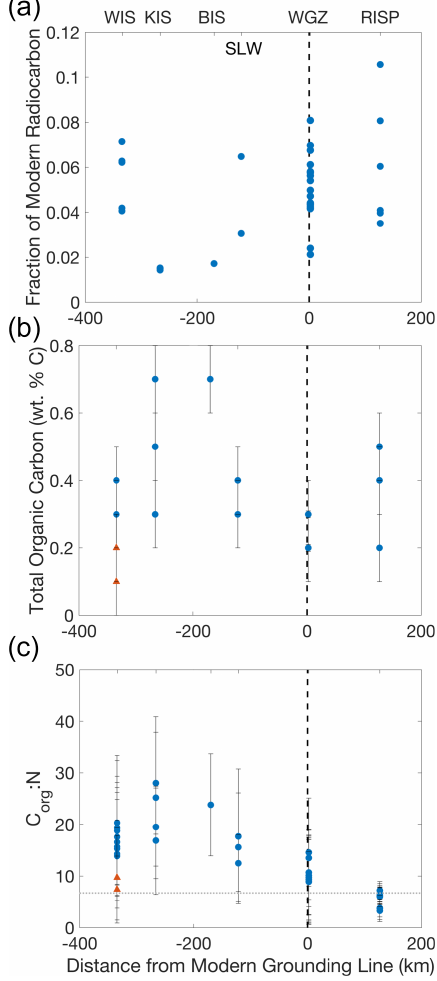
Figure 2. Results of radiocarbon and organic matter analyses for sediment samples taken from beneath grounded ice (SLW, WIS, KIS, BIS), or beneath floating ice (RISP, WGZ), or entrained in basal ice (UC) plotted against sample position with respect to the modern grounding line. (a) Fraction of modern radiocarbon (Fm) measured in acid-insoluble organic matter from bulk sediments. Error bars are smaller than the symbols. (b) Total organic carbon (TOC). (c) C org : N tot (atom:atom). The dotted gray line represents the typical C:N of the ocean (Redfield, 1958). Orange triangles rep- resent the values for sediments recovered from UC basal